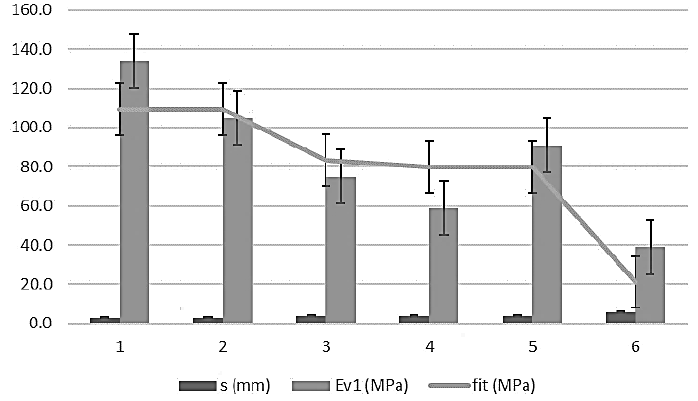
Figure 2. Error bars topographic settlement and first modulus of PLT ( Φ 600mm).